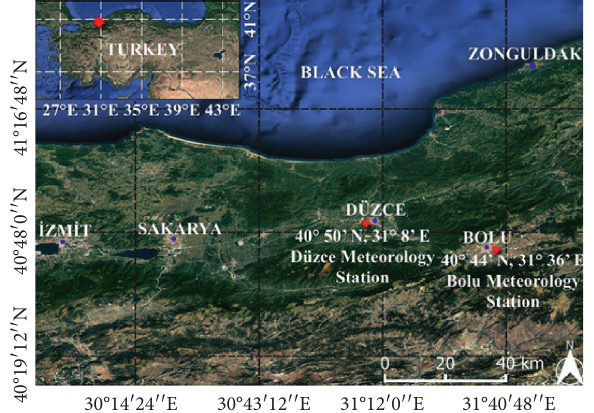
Figure 1: D¨uzce and Bolu meteorology stations with 41km linear